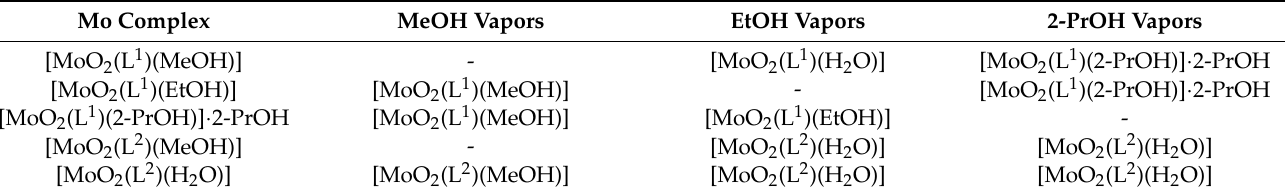
Table 1. Stability tests with different mononuclear